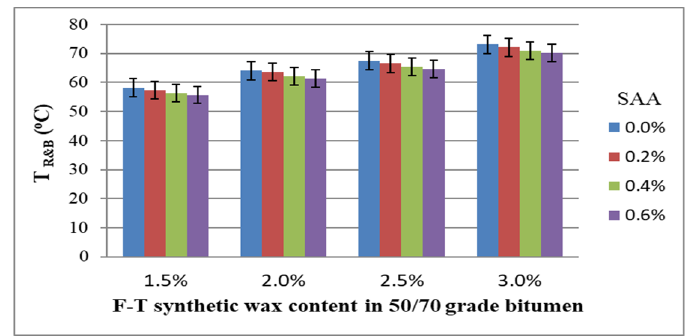
Figure 7. Bitumen 50/70 softening point versus F–T wax and SAA contents.